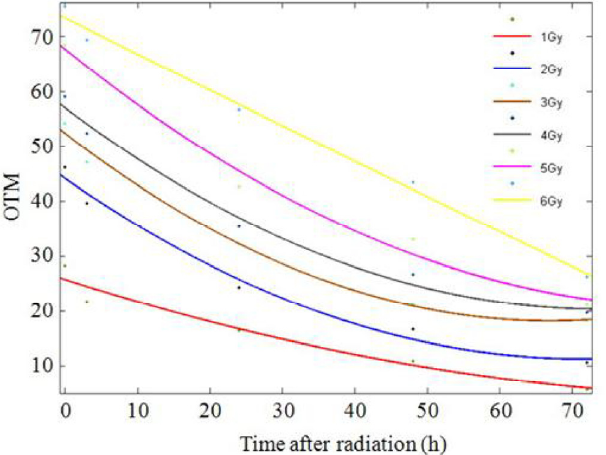
= 0.002119 x 2 − 1Gy = 0.006418 x 2 − 0.918 x + 44.1 2Gy